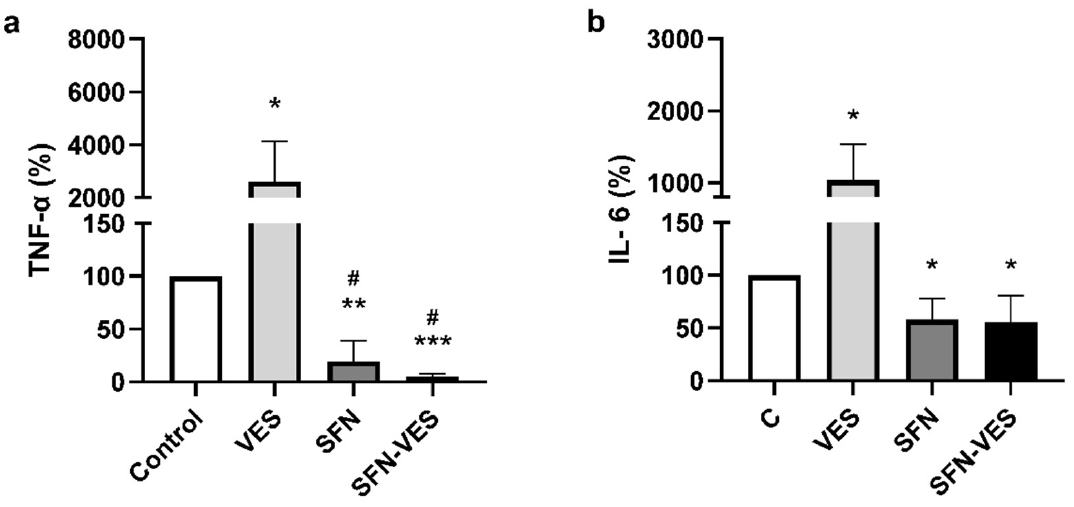
Figure 2. Modulation of human M1 macrophages cytokines production by treatment with Brassica- derived compounds. Unstimulated primary cultures of human M1 macrophages were untreated (control) or treated for 24 h with, unloaded broccoli membrane vesicles 0.02 mg/mL (VES), free sulforaphane 25 µ M (SFN), or SFN-loaded broccoli membrane vesicles at 25 µ M (SFN-VES). TNF- α ( a ) and IL-6 ( b ) cytokine production was assessed from M1 macrophages obtained from 5